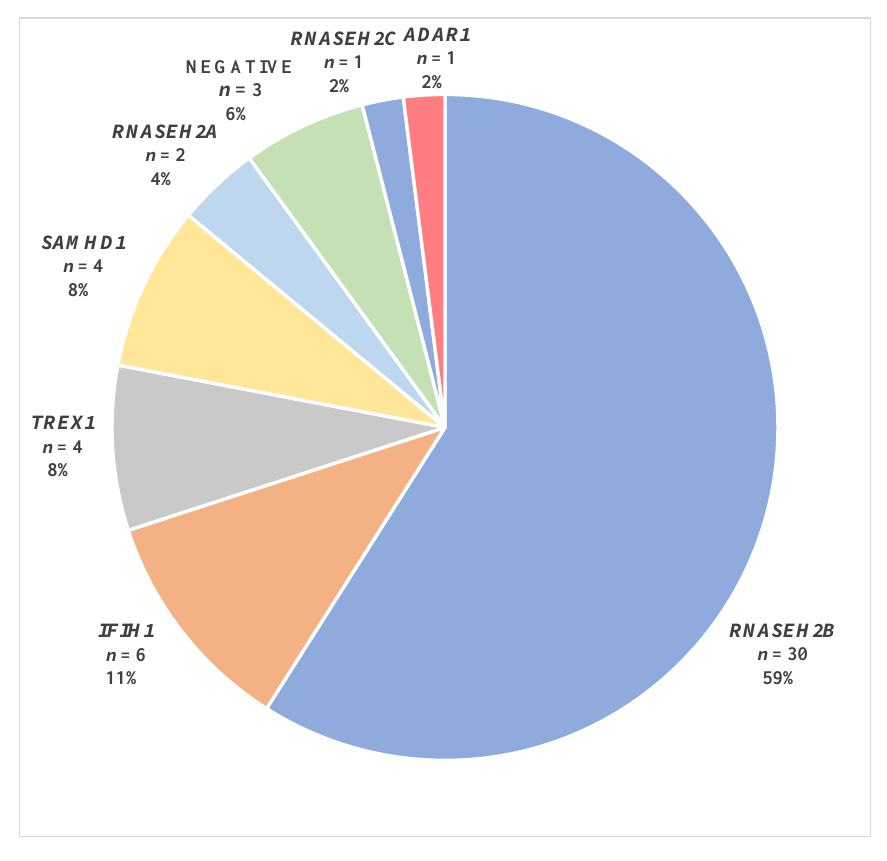
Figure 1. Numbers and percentages of patients with Aicardi – Goutières syndrome with or without mutations in TREX1 , RNASEH2A , RNASEH2B , RNASEH2C , SAMHD1 , ADAR1 and IFIH1 genes.